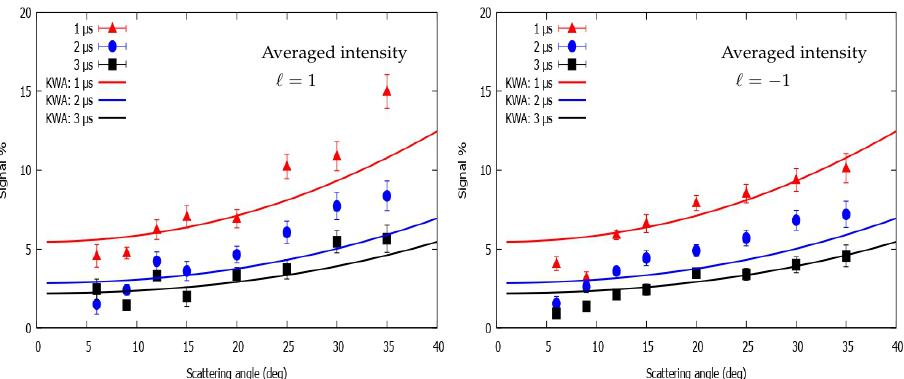
Figure 3. Signal (%) as a function of the scattering angle. The left figure corresponds to the absorption of one photon ( (cid:96) = 1 ) , while the right figure corresponds to the emission of one photon ( (cid:96) = − 1 ) . The points correspond to the experimental results, and the solid lines correspond to the Kroll–Watson approximation results when the laser intensity was